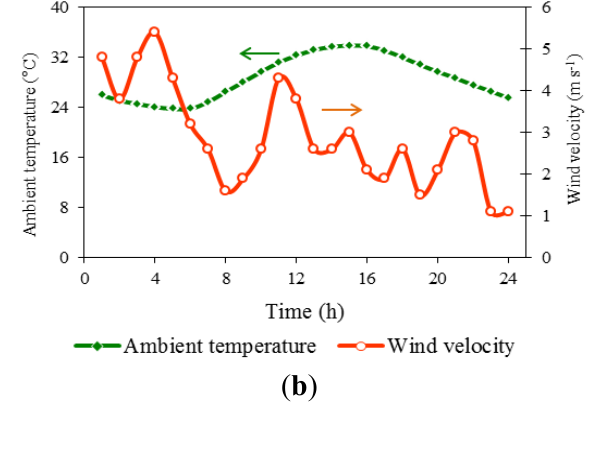
Figure 2. Weather data used in simulation for Tokyo for 28 August 2005: ( a ) solar beam and diffuse radiation and ( b ) ambient temperature and wind